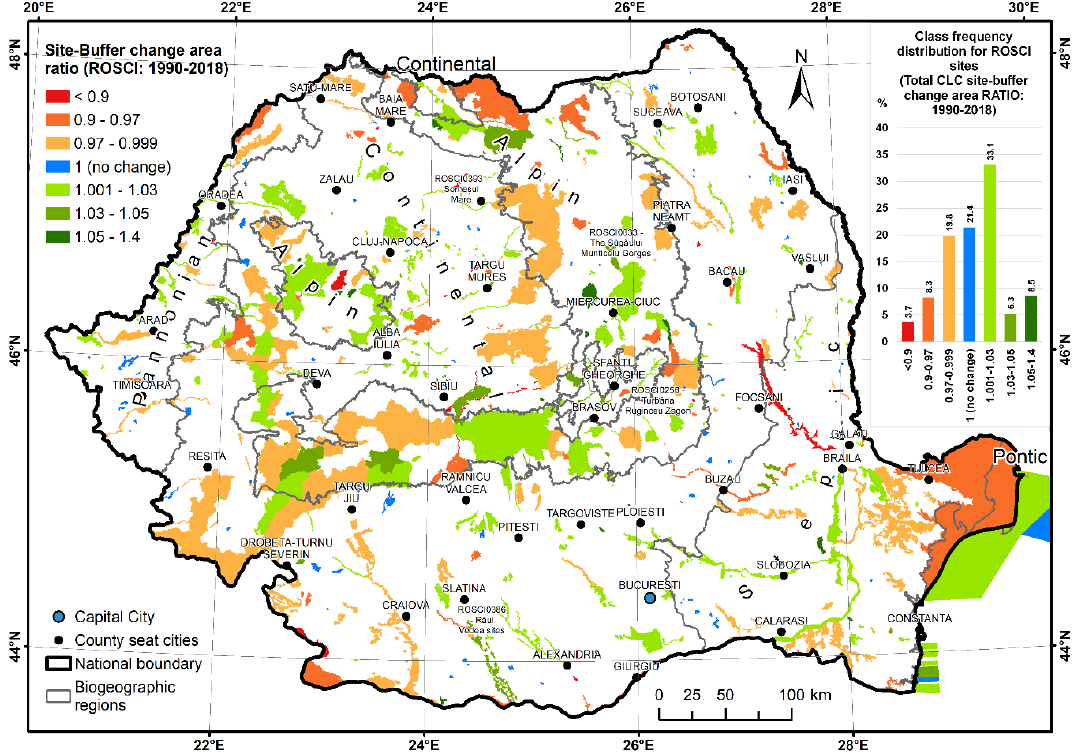
ff er zones (ROSCI